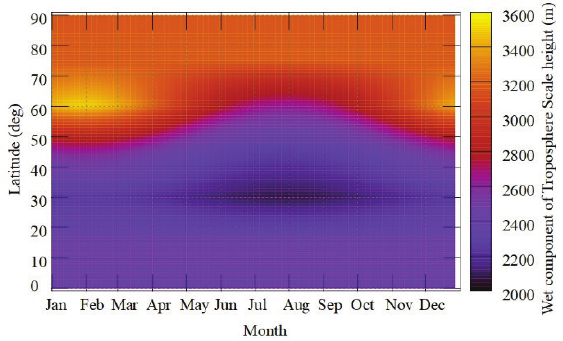
Figure 7. Simulation of the troposphere scale